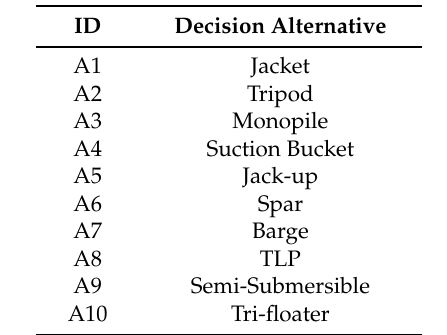
Table 3. List of